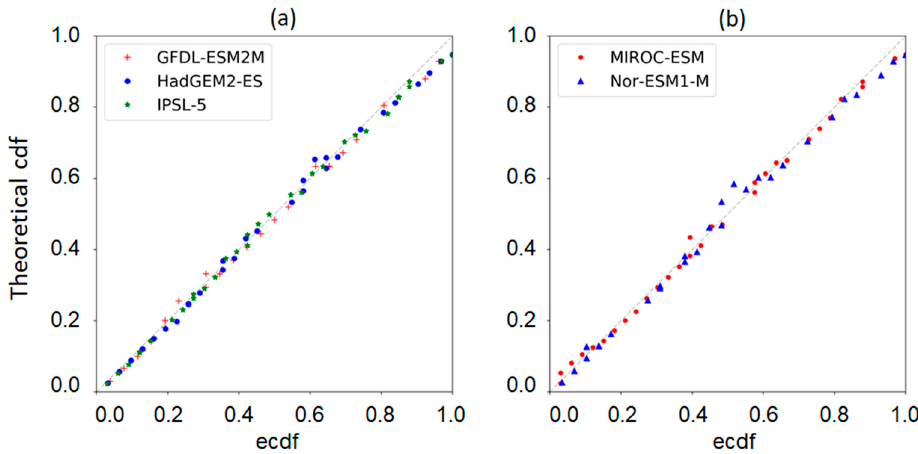
Figure 3. Empirical against theoretical cumulative distribution function from fitted Frank copula. Results correspond to the historical period (1971–2000) and all five driving GCMs: ( a ) GFDL-ESM2M, HadGEM2-ES and IPSL-5; ( b ) MIROC-ESM and